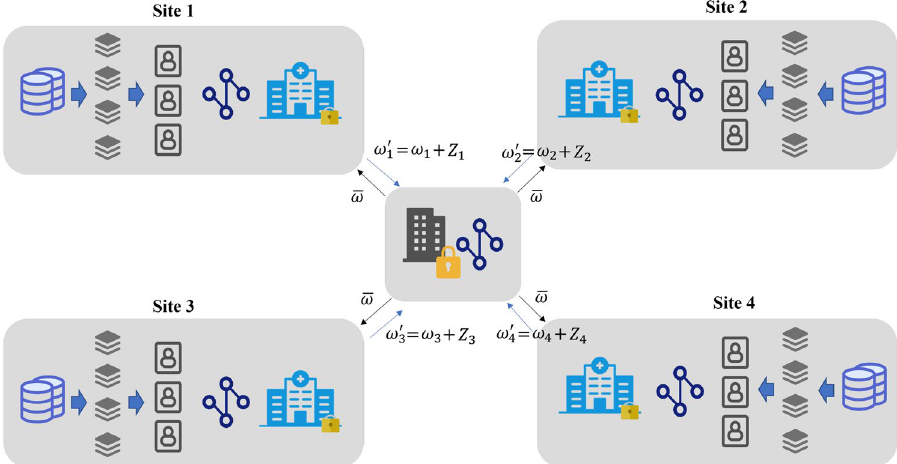
Figure 1. Federated learning with averaging algorithm. The centralized server sends averaged parameter ¯ ω to each local client, and in return, each local client sends ω ′ i = ω i + Z i back to the server, with Z i as the added